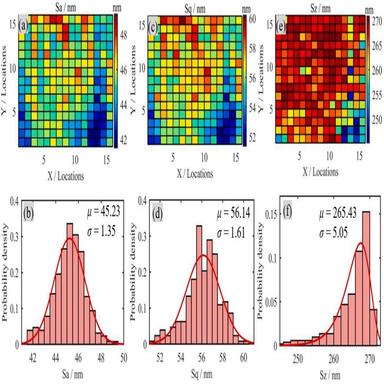
Surface texture parameters of different subarea scales at the machining conditions I of: Sa - (a) the calculated values and (b) the probability distributions, Sq - (c) the calculated values and (d) the probability distributions, and Sz - (e) the calculated values and (f) the probability distributions.